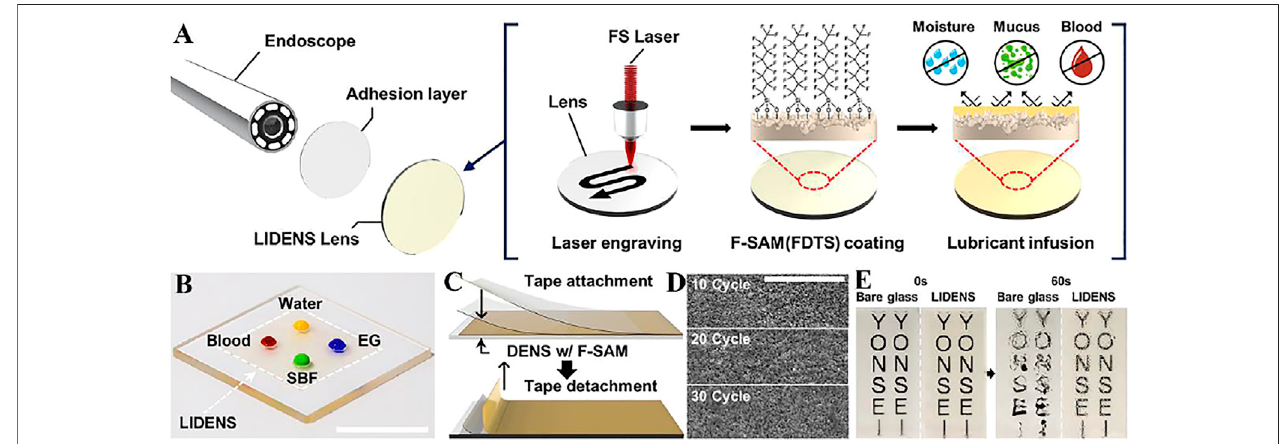
FIGURE4|(A) Manufacturingprocessdiagramofanti-foggingendoscope. (B) PictureofvariousliquidsontheLIDENS(scalebar:1 cm). (C) Schematicdiagramof tape-peeling. (D) SEM images after 10, 20, 30 tape-peel experiment cycles (scale bars: 20 μ m). (E) Continuous photographic images after exposed glass (left) and